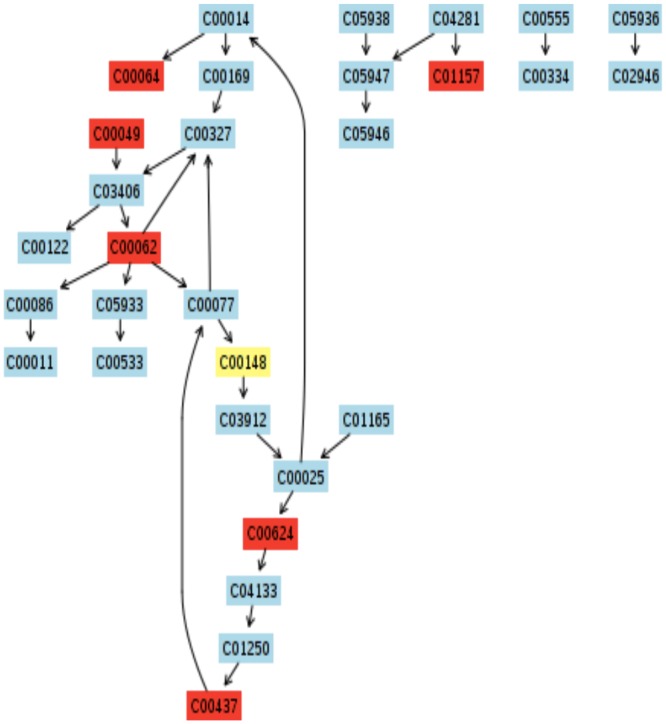
Putative metabolic pathways associated with the wound environment of chronic pressure ulcers.Significantly contributing pathway nodes arginine and proline metabolism. Highlighted metabolites indicated hits from the metabolic profiling and are coded according to p-value. Pathway maps are generated using the KEGG reference map (http://www.kegg.jp/kegg/pathway.html).